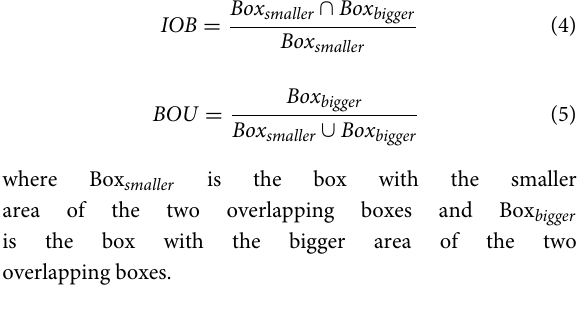
FIGURE6 Performance of the PanicleDetect